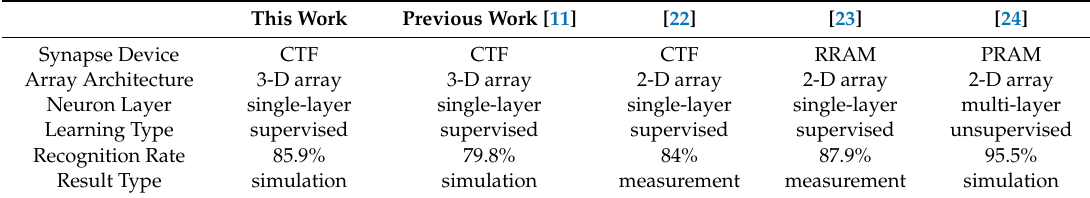
Table 3. Comparison between several research results of neuromorphic